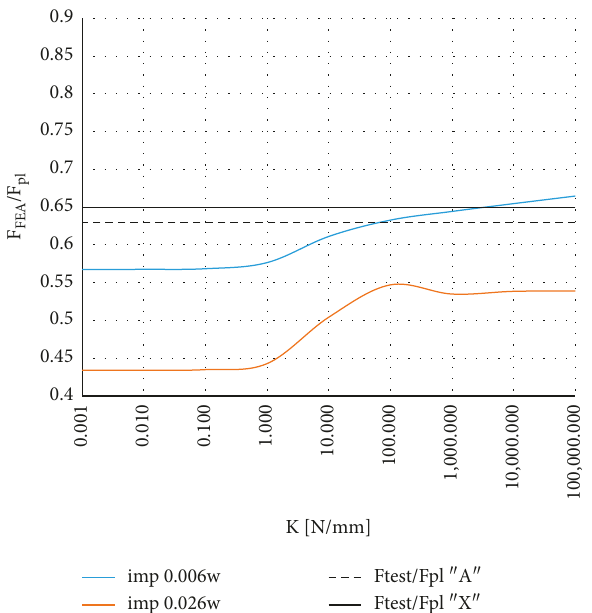
Figure 19: Numerical results for the normalized ultimate load as a function of spring stiffness of the 300mm column.